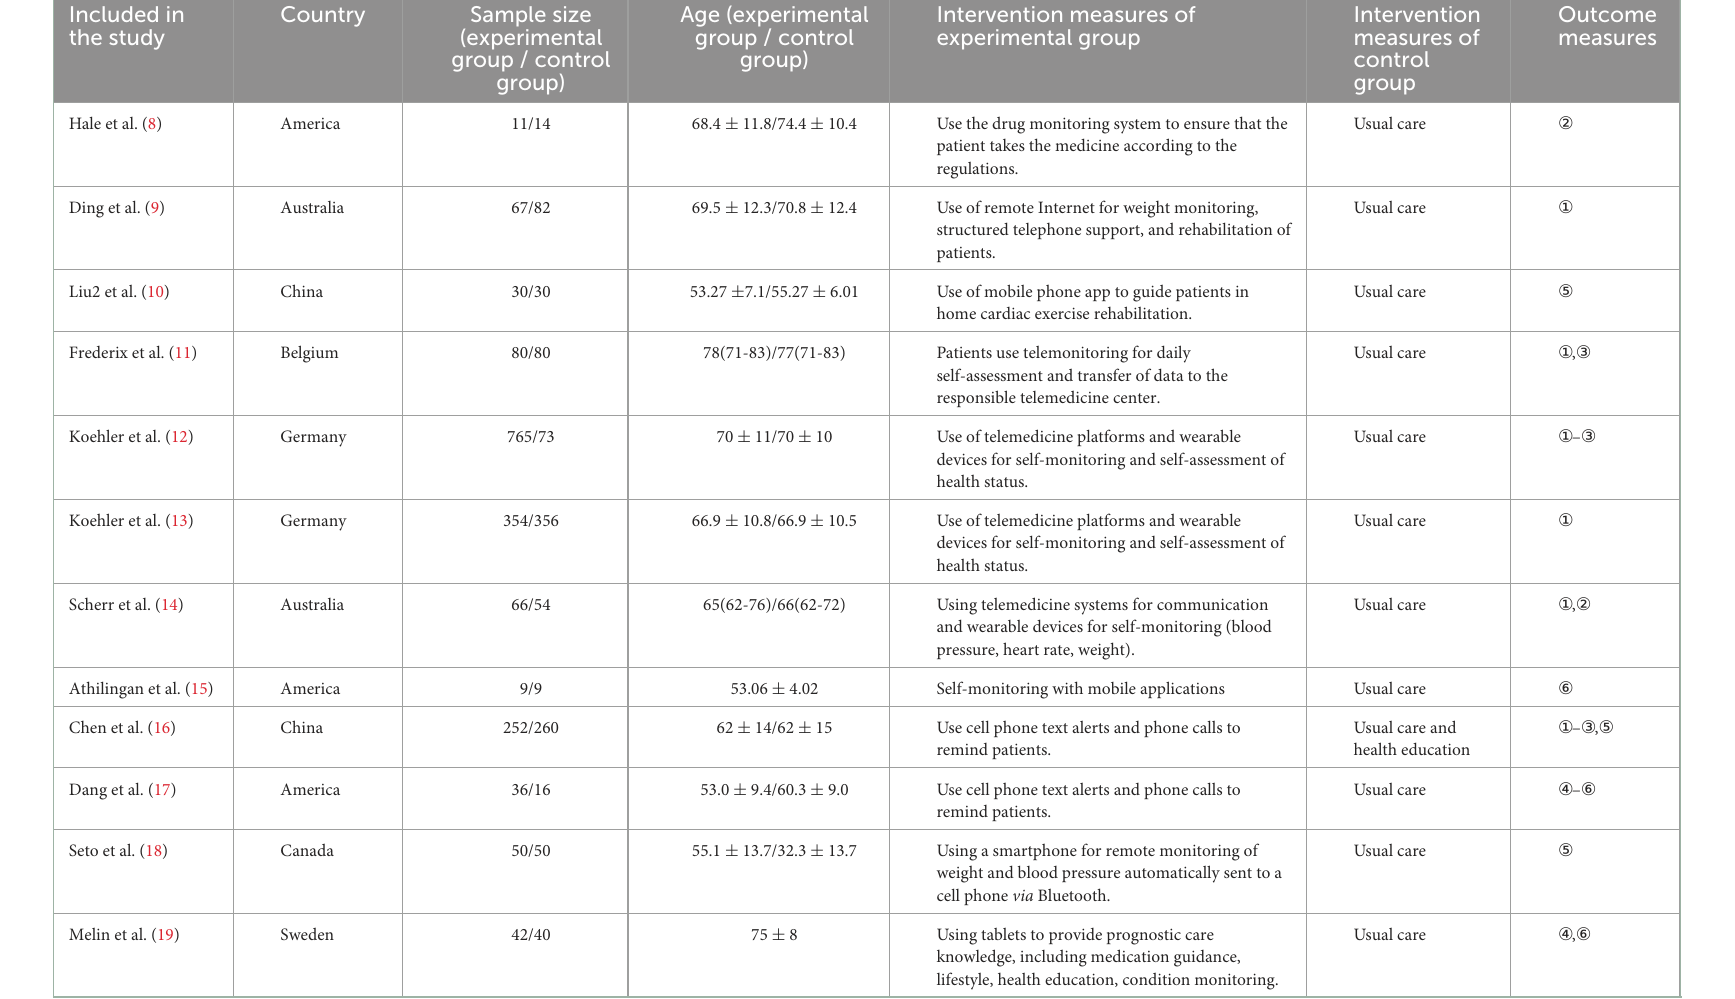
TABLE 1 Characteristics of included